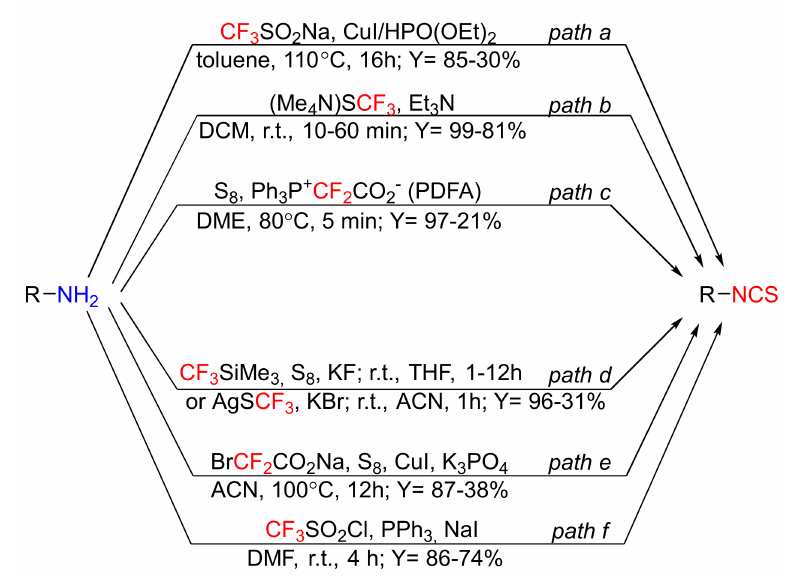
Figure 14. Synthesis of ITCs using fluorine-containing